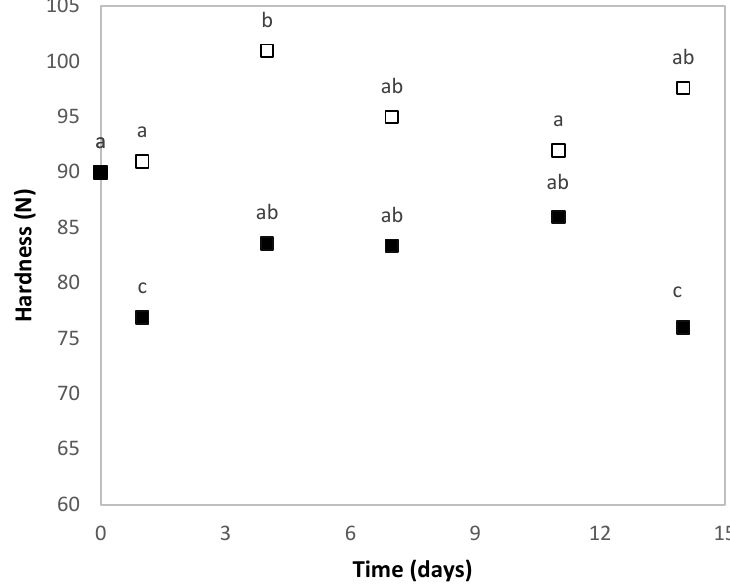
Figure 4. Hardness (N) of minimally processed apples as function of storage time for samples stored 14 days at 4 °C. Control sample ( ■ ); coated sample (□). Different letters correspond samples significant effect due to time effect.